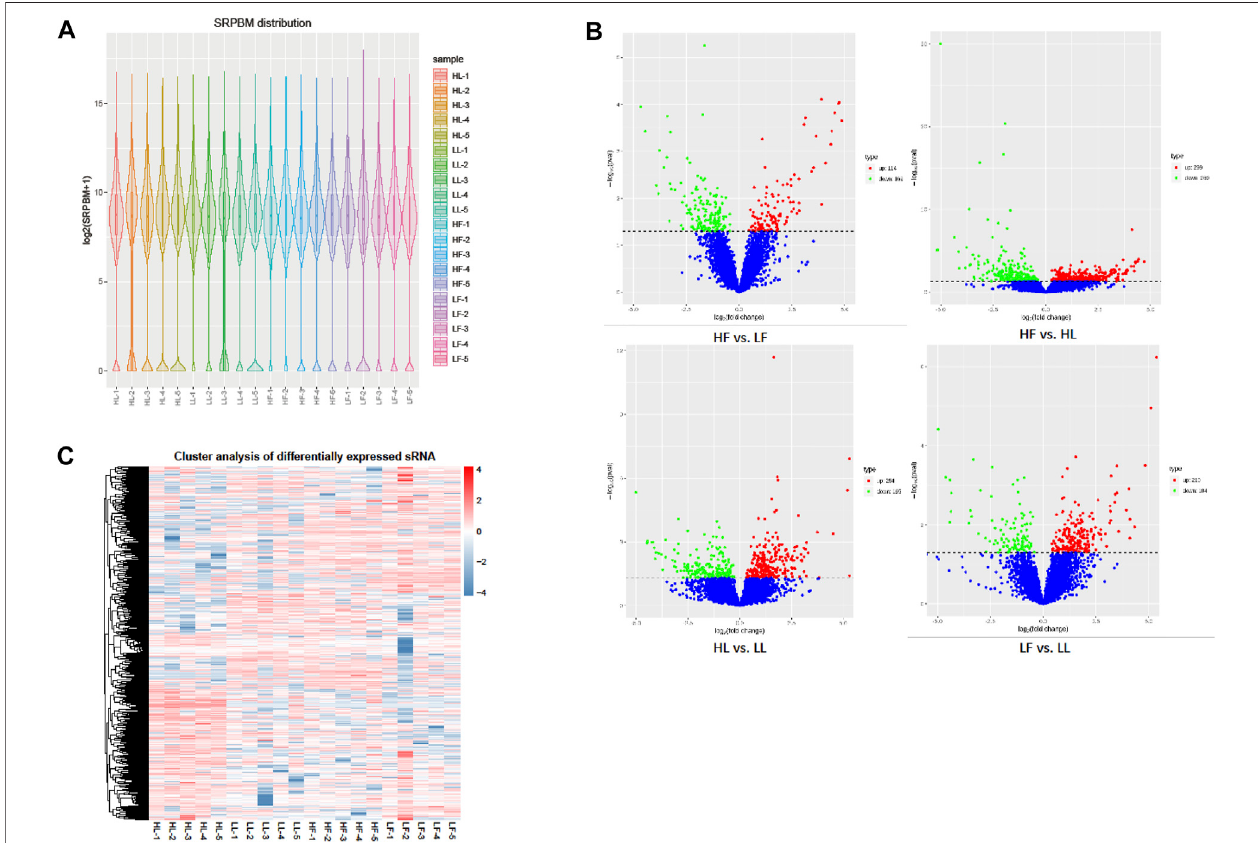
FIGURE 3 | DE circRNA screening and clustering analysis. (A) : The distribution of circRNA expression levels in each sample. The expression of circRNAs was normalizedbySRPBM. (B) :ThevolcanoplotofDEcircRNAs inthefourcomparisons.The X -axisrepresentsthechangeincircRNAexpression indifferentcomparisons. The Y -axis representsthe statistical signi fi cance ofcircRNAs. The blue dots represent the circRNAs that were notsigni fi cantlydifferent, the red dots represent circRNAs that weresigni fi cantlyupregulated, and the green dotsrepresentcircRNAs that weresigni fi cantlydownregulated. (C) :Theclusteringdiagram ofDEcircRNAs. The expression was gradually upregulated from blue to red.